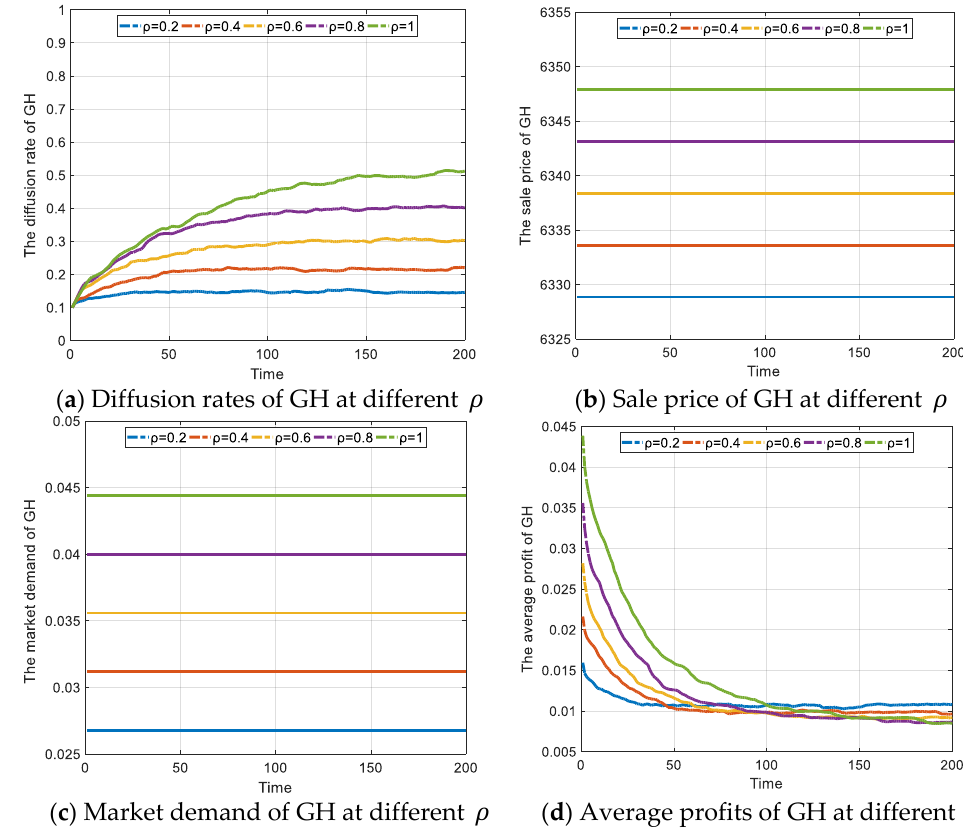
Figure 5. The effect of OH restriction policy on GH diffusion (Unit: CNY). Table 6. The diffusion rate of GH with different ρ . ρ 0.2 0.4 0.6 0.8 1 The diffusion rate of GH (max) 0.1543 0.221 0.3082 0.4061